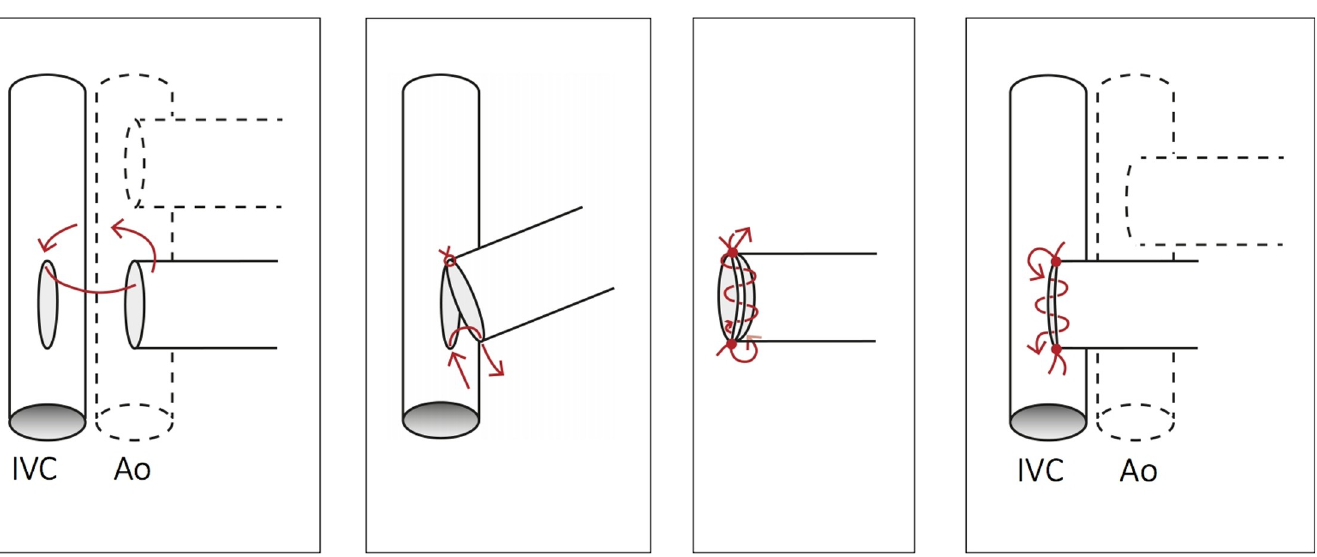
PLOS ONE | https://doi.org/10.1371/journal.pone.0214513 April 12,